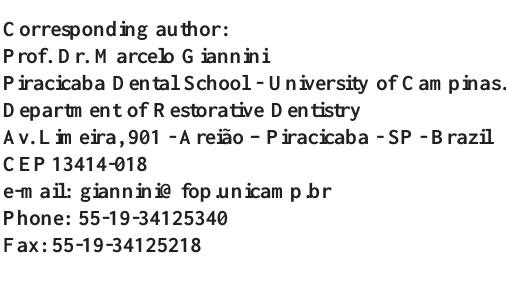
composite resin. Am J Dent 1993;